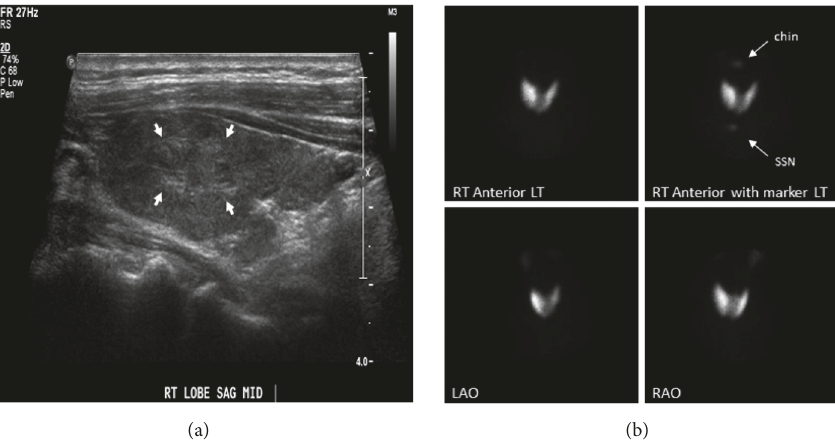
Figure 1: Thyroidultrasoundandnuclearscan .Grayscale sonographicimage of therightthyroid lobedemonstratesa heterogeneousnodule with ill-defined borders (arrows) (a);technetium-99mpertechnetatethyroid scan showing increaseduptake inboth thyroid lobeswith a more focal hot nodule in the superior to mid portion of the right lobe, corresponding to the nodule seen on ultrasound